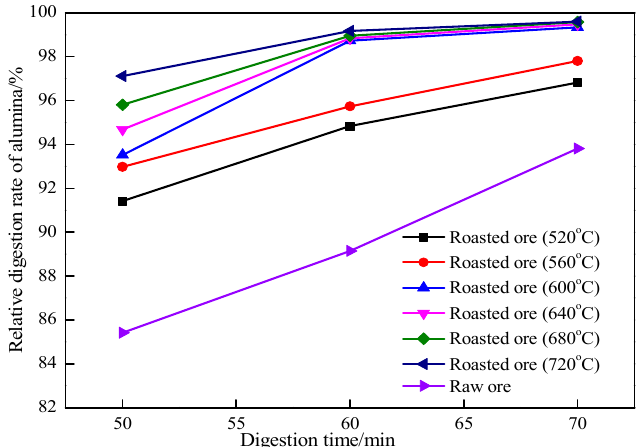
Figure 9. Effect of digestion time on the relative digestion rate under the conditions of 260 °C digestion temperature, 9% lime addition, 236 g/L caustic concentration, and 1.50 ingredient molecular ratio.